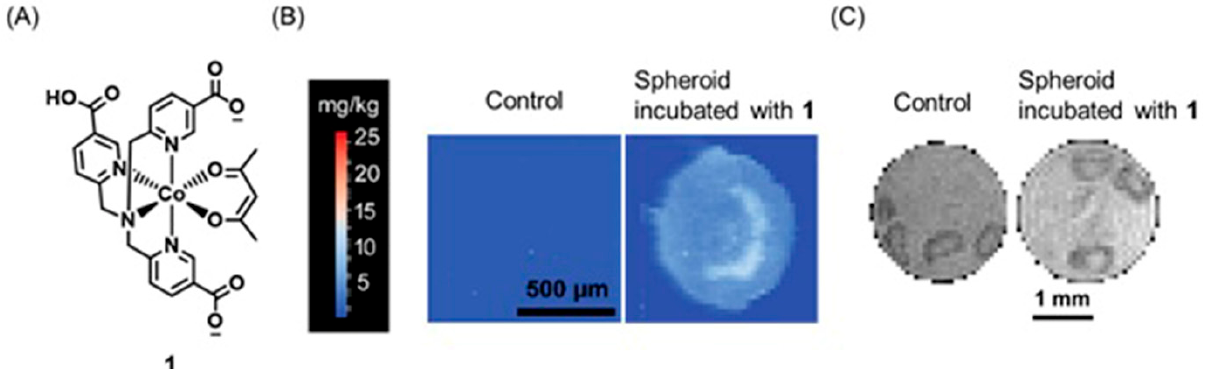
Figure 2. ( A ) Chemical structure of 1 in its Co III oxidation state. ( B ) Laser ablation inductively coupled plasma mass spectrometric images of the control sample and tumor spheroid incubated with 1 . ( C ) T 1 -weighted MR images of the control sample and tumor spheroid incubated with 1 . Both laser ablation inductively coupled plasma mass spectrometric image and T 1 -weighted image of the tumor spheroid incubated with 1 showed accumulation of 1 in the inner hypoxic regions which is known to have a reducing and acidic environment. Adapted with permission from O’Neill, E. S.; Kaur,